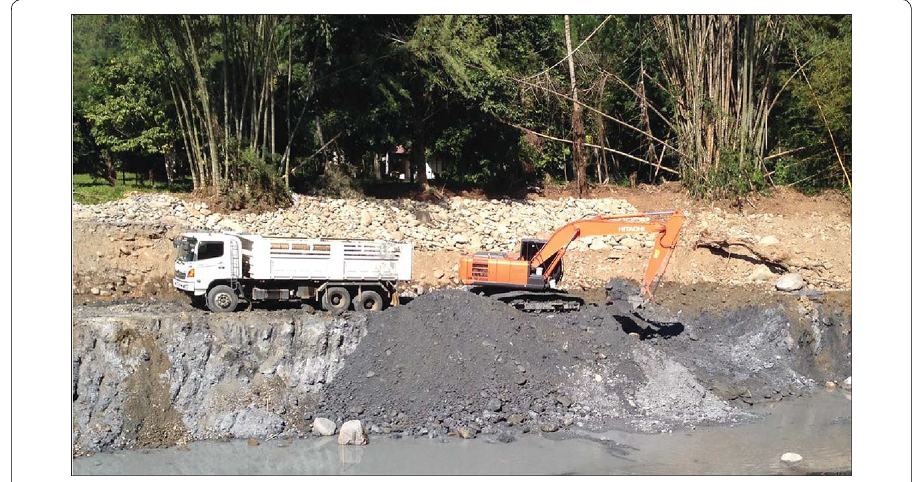
Fig. 14 Photograph during January, 2016 excavation of pit into dark-gray sheared quartzite, sheared pieces embedded in gray gummy clay. Resulting reservoir is ~ 12 m deep. This clayey material apparently lies within or beneath the quartzite just east of the hot springs. No bedding planes observed (clean exposure is left side of photo). No pyrite or visible mineralization observed in the clay or rock. Location is 0516550E,